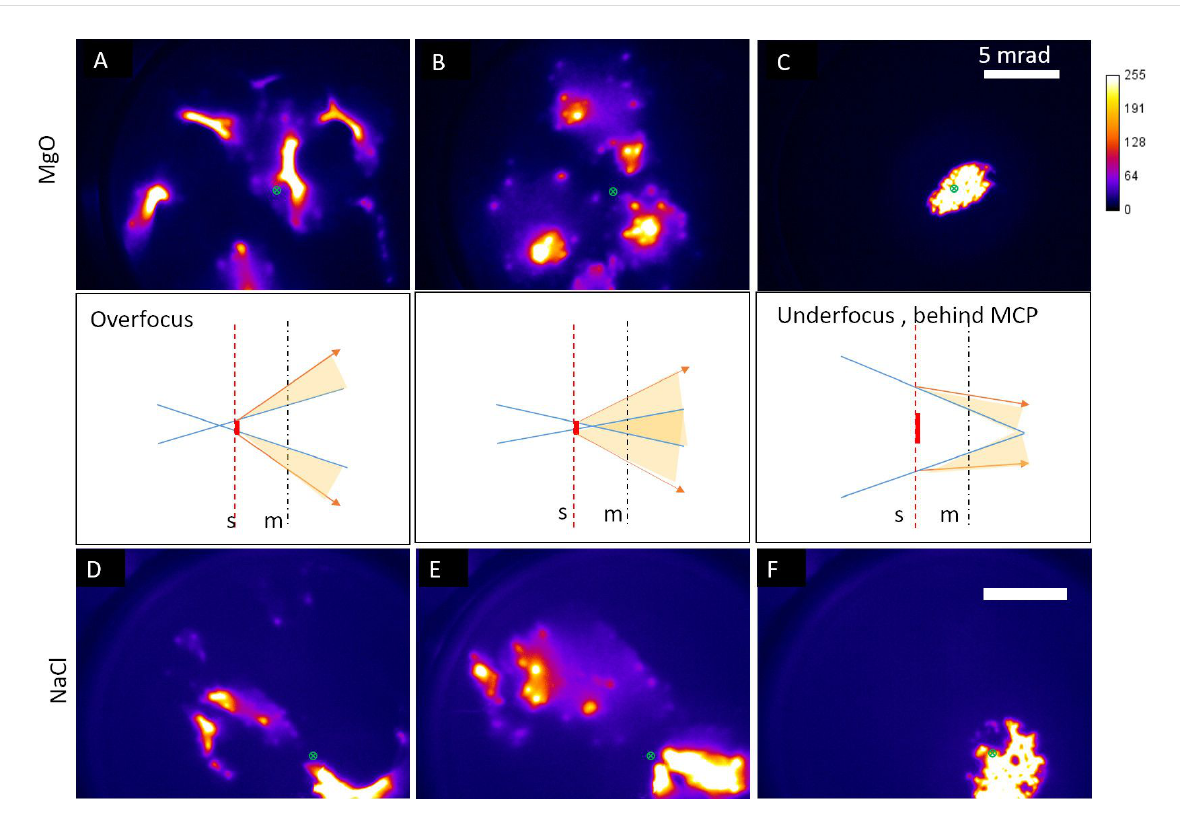
Figure 3: Examples of overfocus bright outline deflection patterns (A and D), underfocus spot patterns (B and E), and underfocus images (C and F) recorded for MgO (A–C) and NaCl (D–F). The scale bar in C is 5 mrad and applies to A–C. The scale bar in F is 5 mrad and applies to D–F. The color bar shows the grayscale pixel value recorded in the CCD image. The schematics in the middle row show the different deflection situations for a single positively charged particle in the path of the ion beam. The blue lines represent undeflected trajectories while the orange arrows and shaded areas show a collection of deflected trajectories. The dashed red line (s) shows the sample plane and the dot-dashed black line (m) shows the MCP